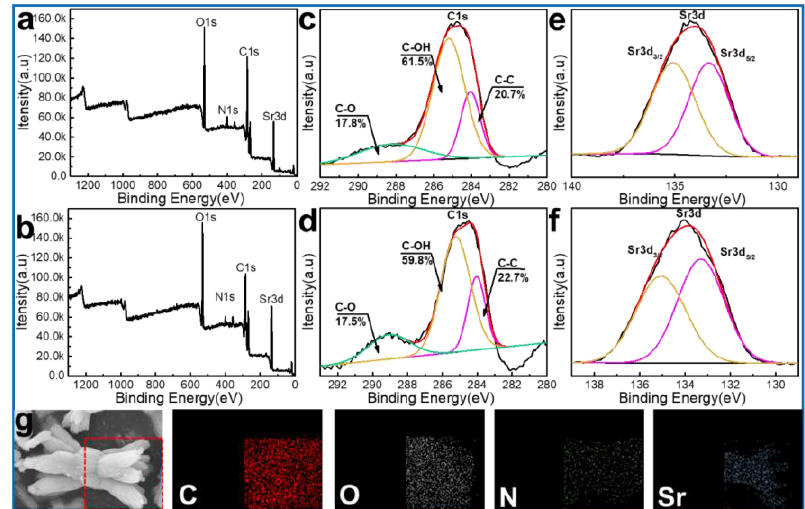
Figure 6. X-ray photoelectron spectroscopy (XPS) spectrum of SrCO 3 obtained in the absence of nano-MMT ( a ) and the presence of nano-MMT ( b ), respectively. C1s in the absence of nano-MMT ( c ) and the presence of nano-MMT ( d ), respectively. Sr3d in the absence of nano-MMT ( e ) and the presence of nano-MMT ( f ), respectively. ( g ) The EDS element mapping of the SrCO 3 obtained in the presence of nano-MMT.